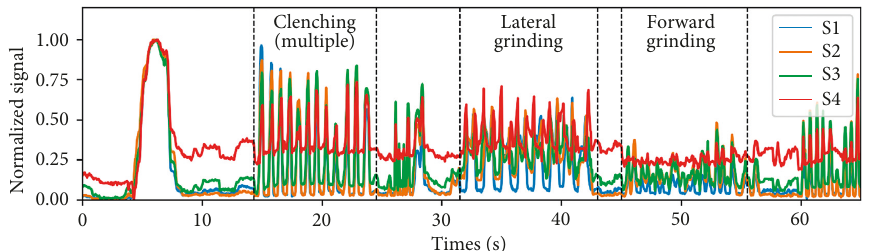
Figure 2: Typical output of the prototype appliances in response to different jaw movements by the subject. Each signal is normalised to the peak of the sustained clenching event occurring at t � 6